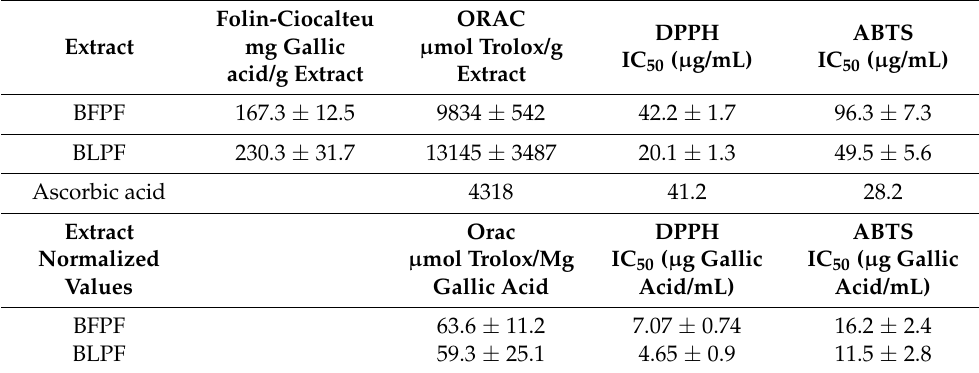
Table 6. Total phenolic content and antioxidant activity mean values ( ± SD) of the two tested extracts, absolute values and values normalized on total phenolic content.